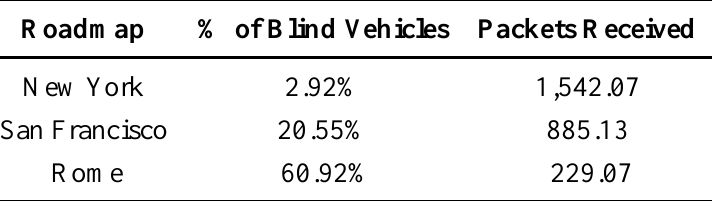
Table 10. Blind vehicles and packets received per vehicle when varying the